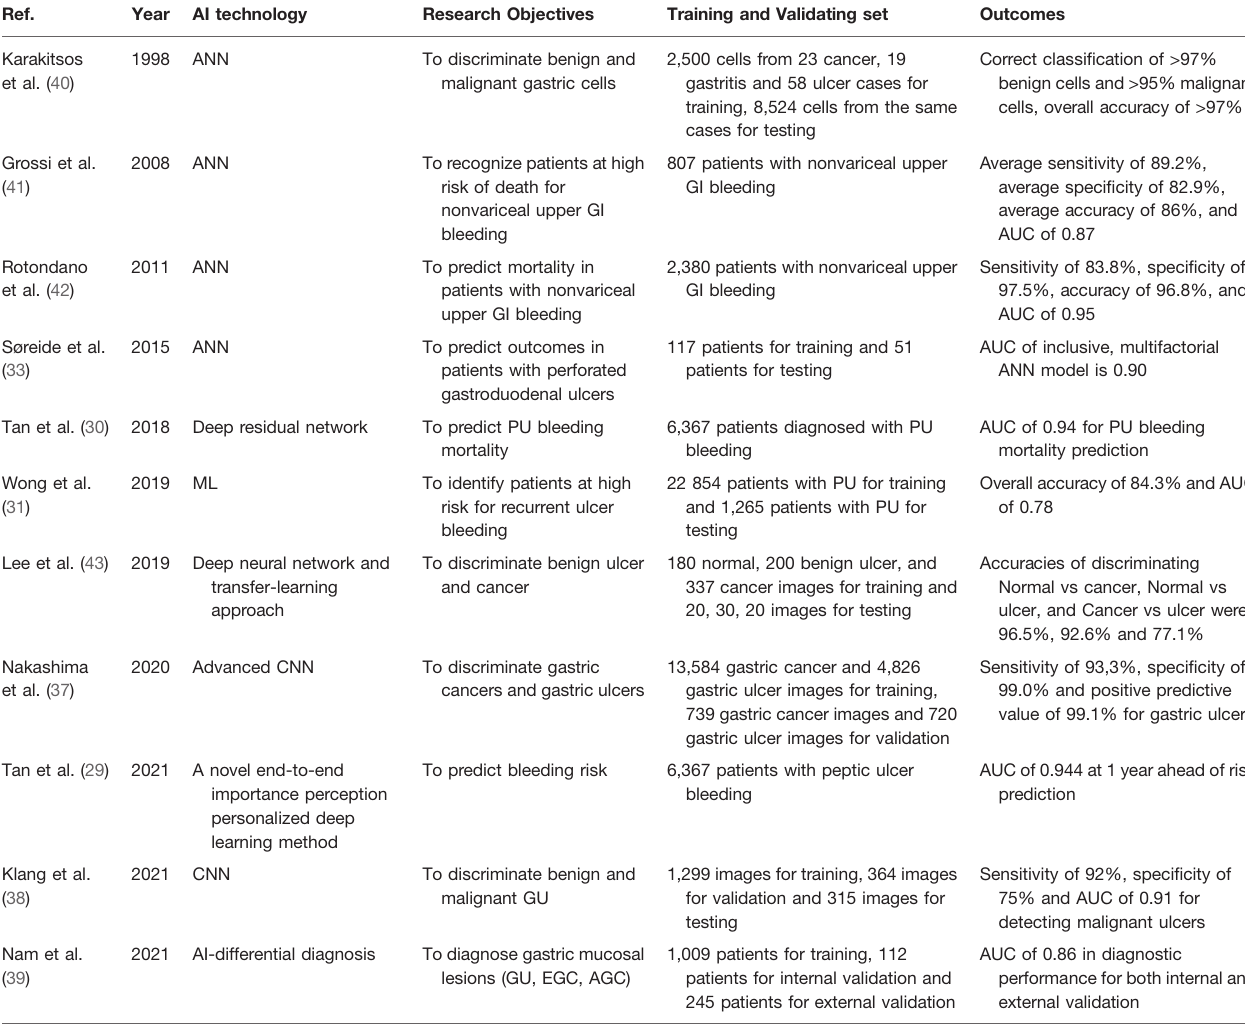
TABLE 1 | Summary of applications of AI in PU ’ s complications.